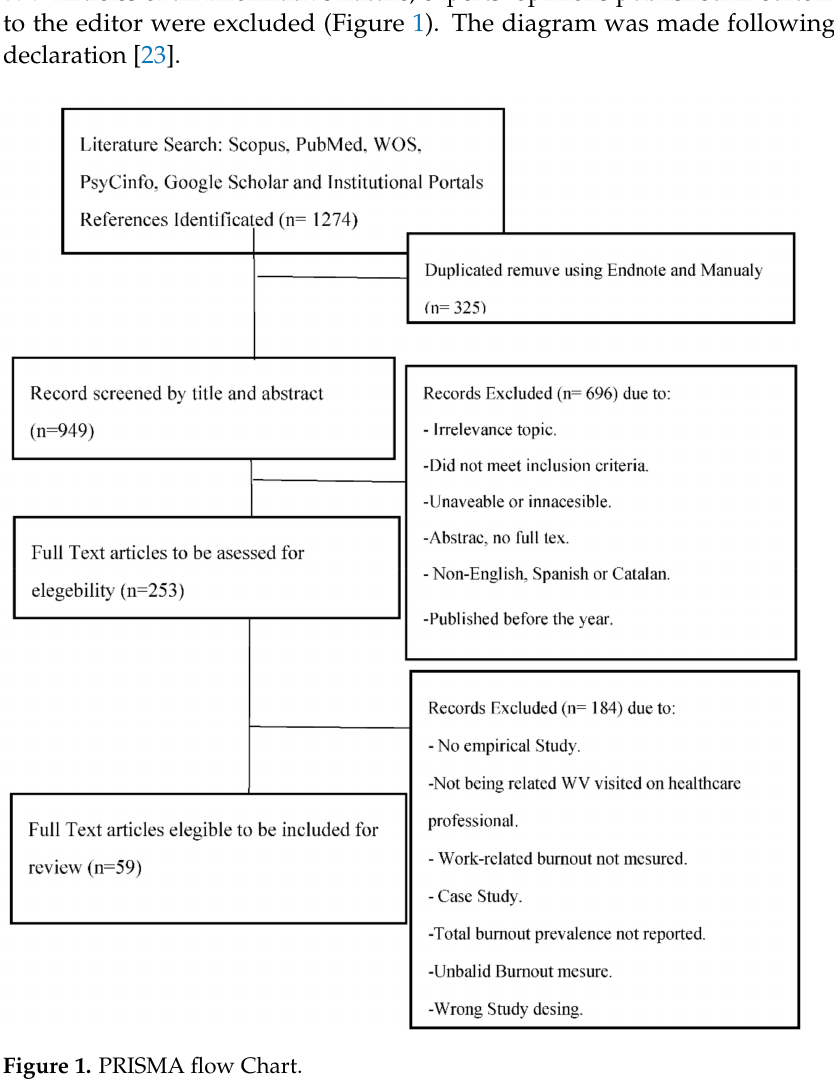
Figure 1. PRISMA flow